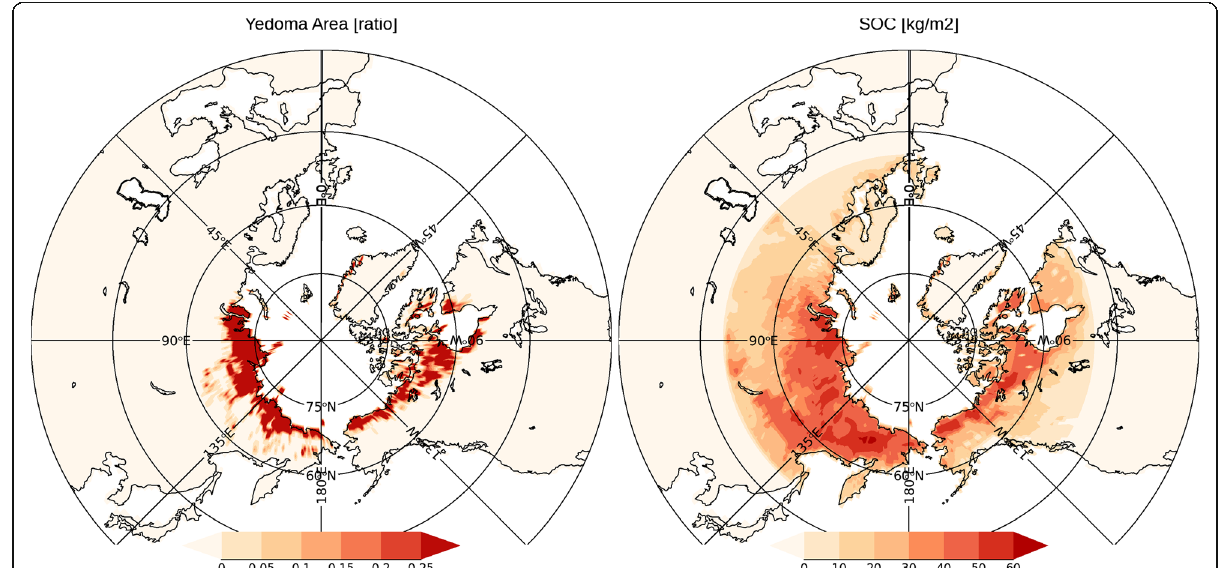
Fig. 1 (Left) Yedoma area used in the model simulation (unit = ratio to grid area); (right) soil organic carbon used in the model simulation (unit = kg/m 2